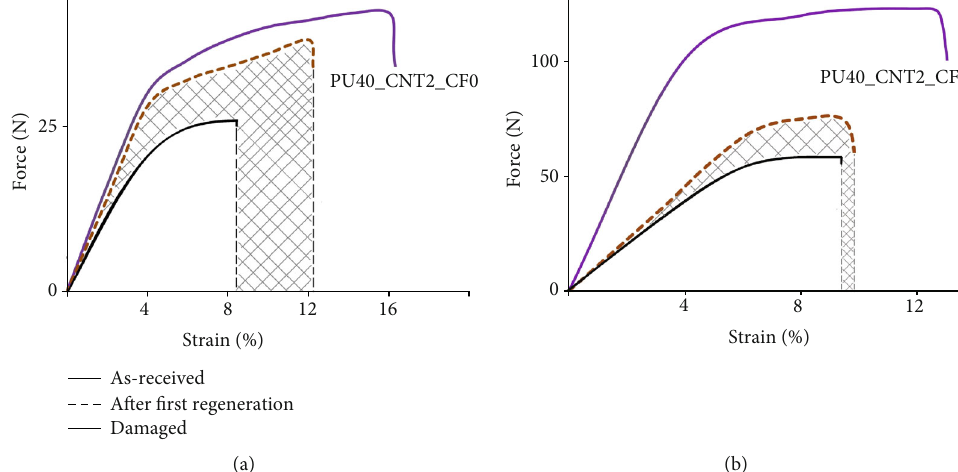
Figure 12: Force-strain plots of the nanocomposites before and after self-healing; (a) PU modi fi ed with CNT-OH, (b) PU modi fi ed with CNT-OH and CF. Table 4: Comparison of fracture works of undamaged, damaged, and healed samples under tensile tests. Type of